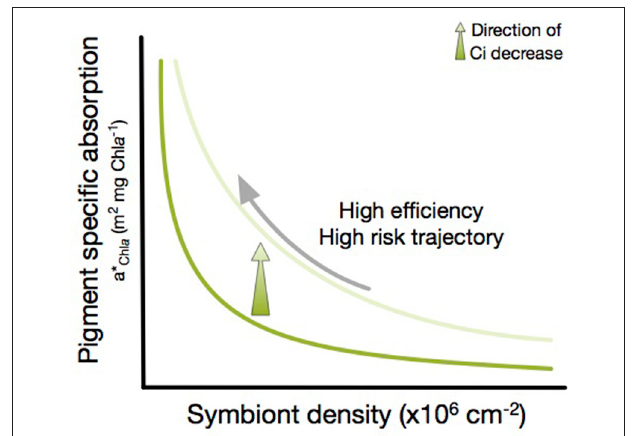
FIGURE 7 | Theoretical scheme of the modulating effect of Symbiodinium Ci on the association of a * Chl a with changes in symbiont density. The lower (dark green) line shows the variation of a * Chl a with a constant Ci calculated form the standard deviation above the mean Ci (high Ci condition). The upper (light green) line shows the variation with a constant Ci value calculated from the standard deviation below the mean Ci. The green arrow indicates the direction of a * Chl a increases when a stable symbiont density decreases its Ci. The upper trajectory leads to faster increase in a * Chl a , but also a higher risk of collection too much light under heat stress and suffering higher photo-damage. The real trajectories for each species can be found in Supplementary Figure